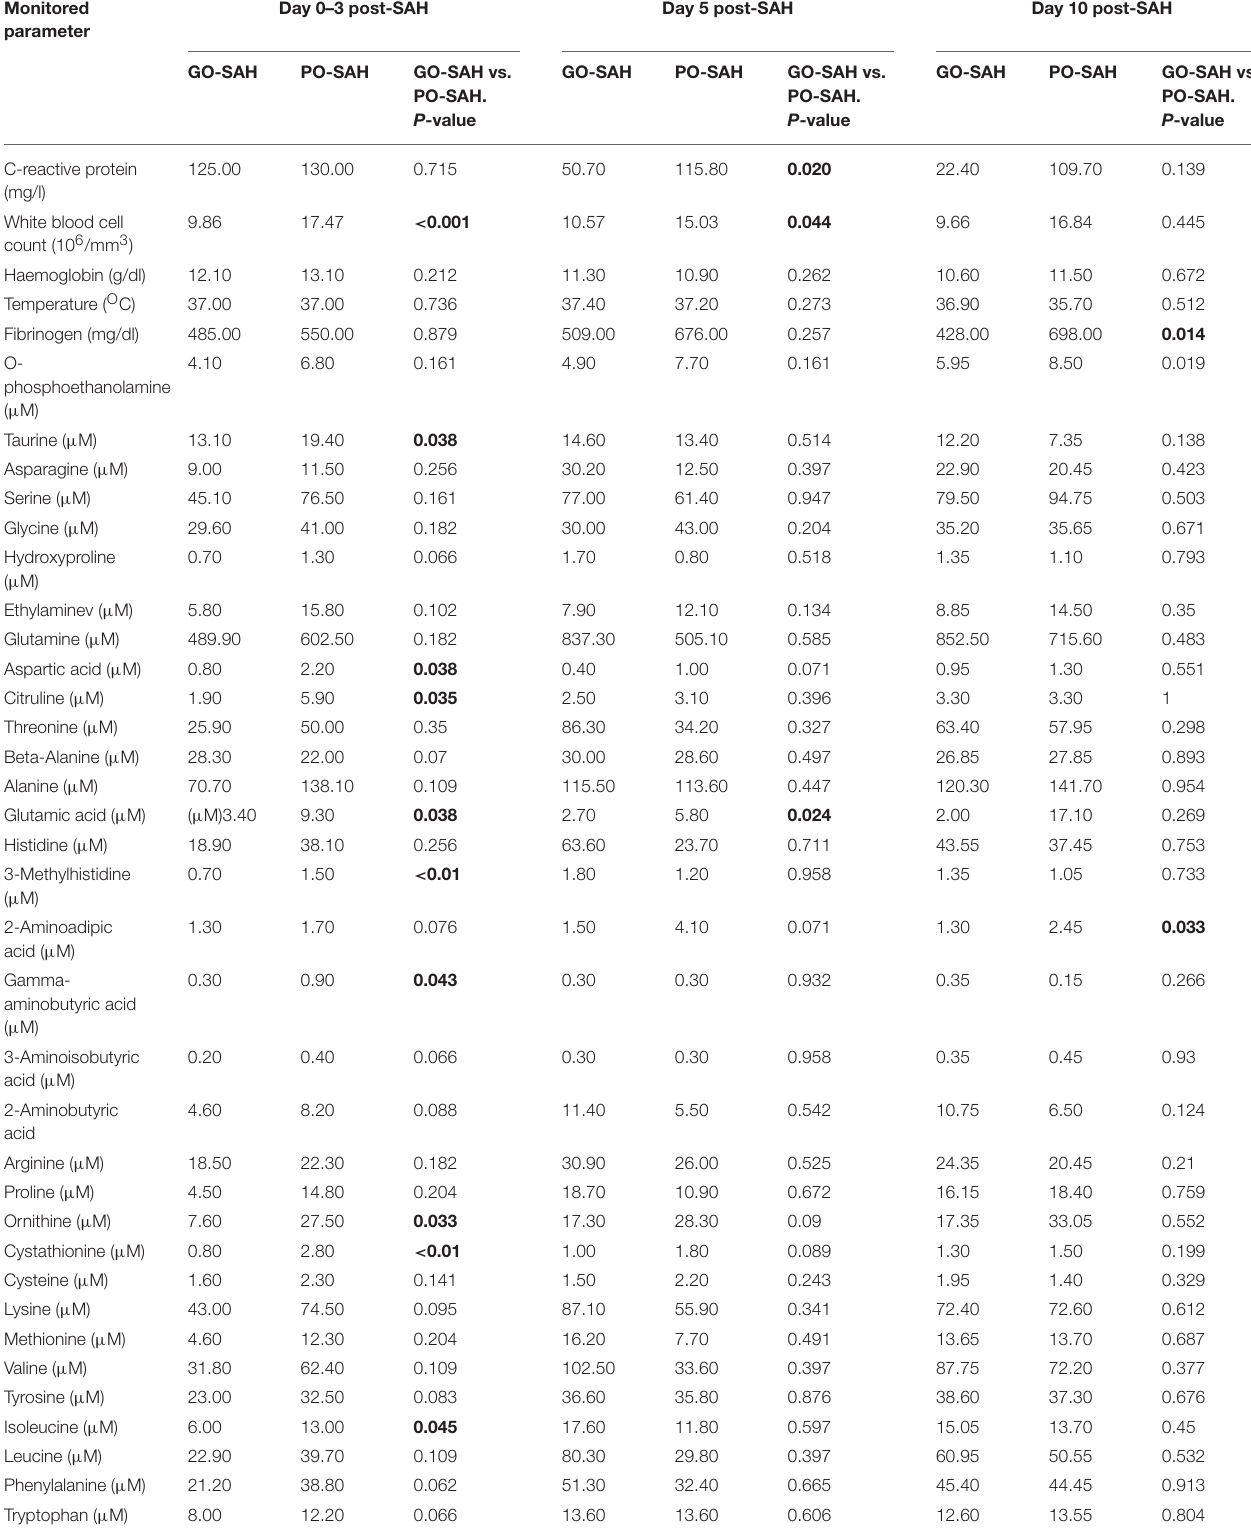
TABLE 3 | Differences in monitored parameters at day 0-3, 5, and 10 post-SAH in patients with good (GO-SAH) and poor (PO-SAH) treatment outcome. Monitored parameter